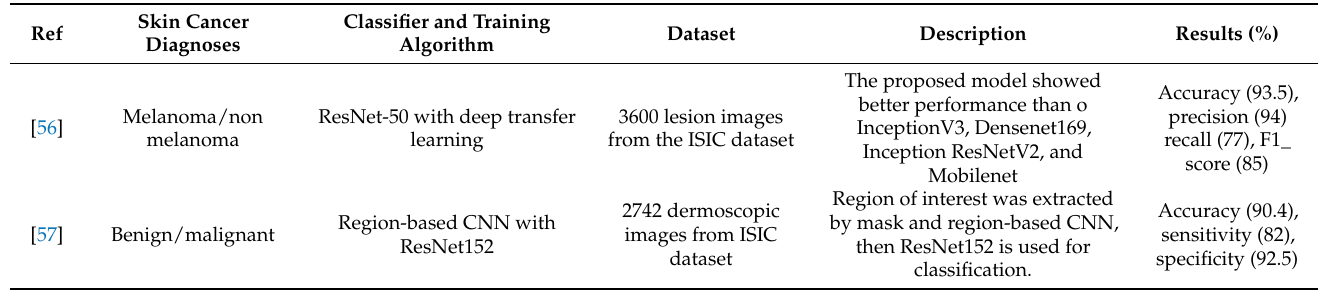
Table 6. A comparative analysis of skin cancer detection using CNN-based approaches.